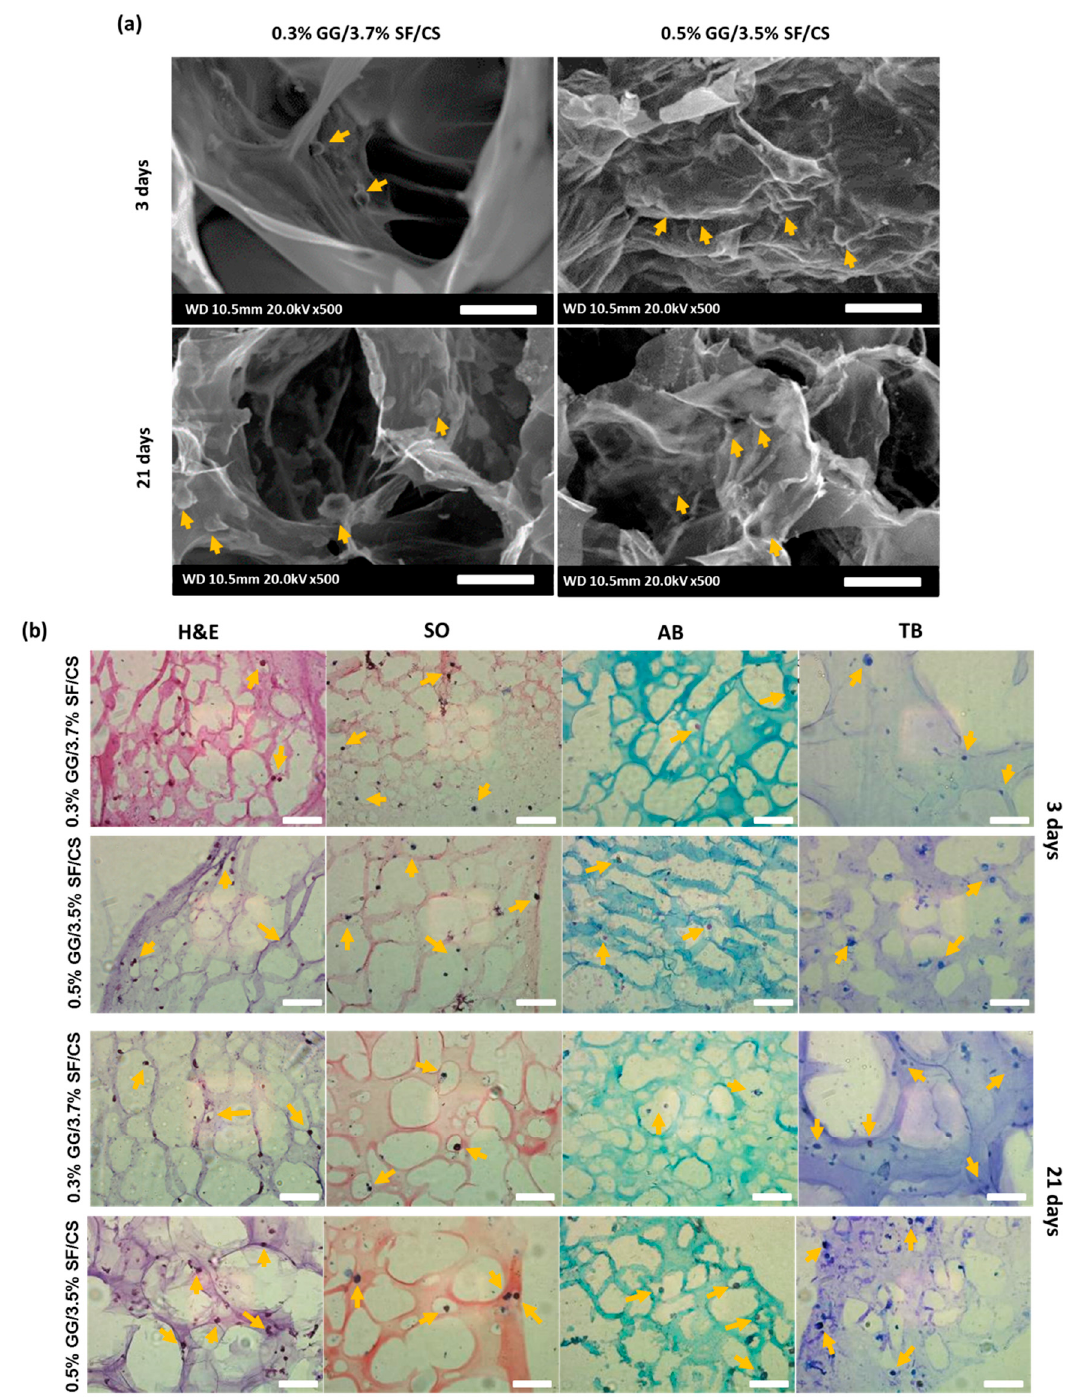
Figure 7. ( a ) Morphological observation of the cell-laden hydrogels under SEM analyzed on 3 and 21 days of culture. The cells were observed on 21 days of culture in both groups, which may be due to the proliferation of cells in the matrix (scale bar = 50 µ m), and ( b ) histological analysis (H&E, SO, AB, and TB) was observed with the cell-laden hydrogels cells cultured in the ternary hydrogels for 3 and 21 days. On 21 days, the cell attachment in hydrogels occurred well, and cell proliferation occurred (scale bar = 25 µ m).